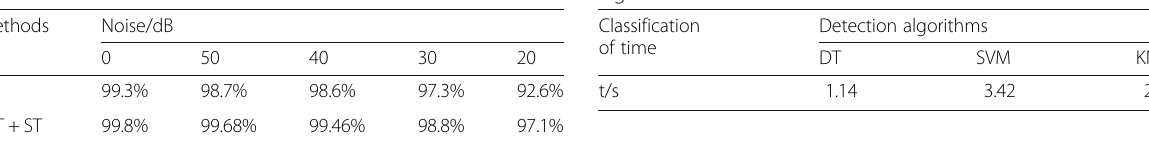
Table 4 Classification time comparison of different detection algorithms